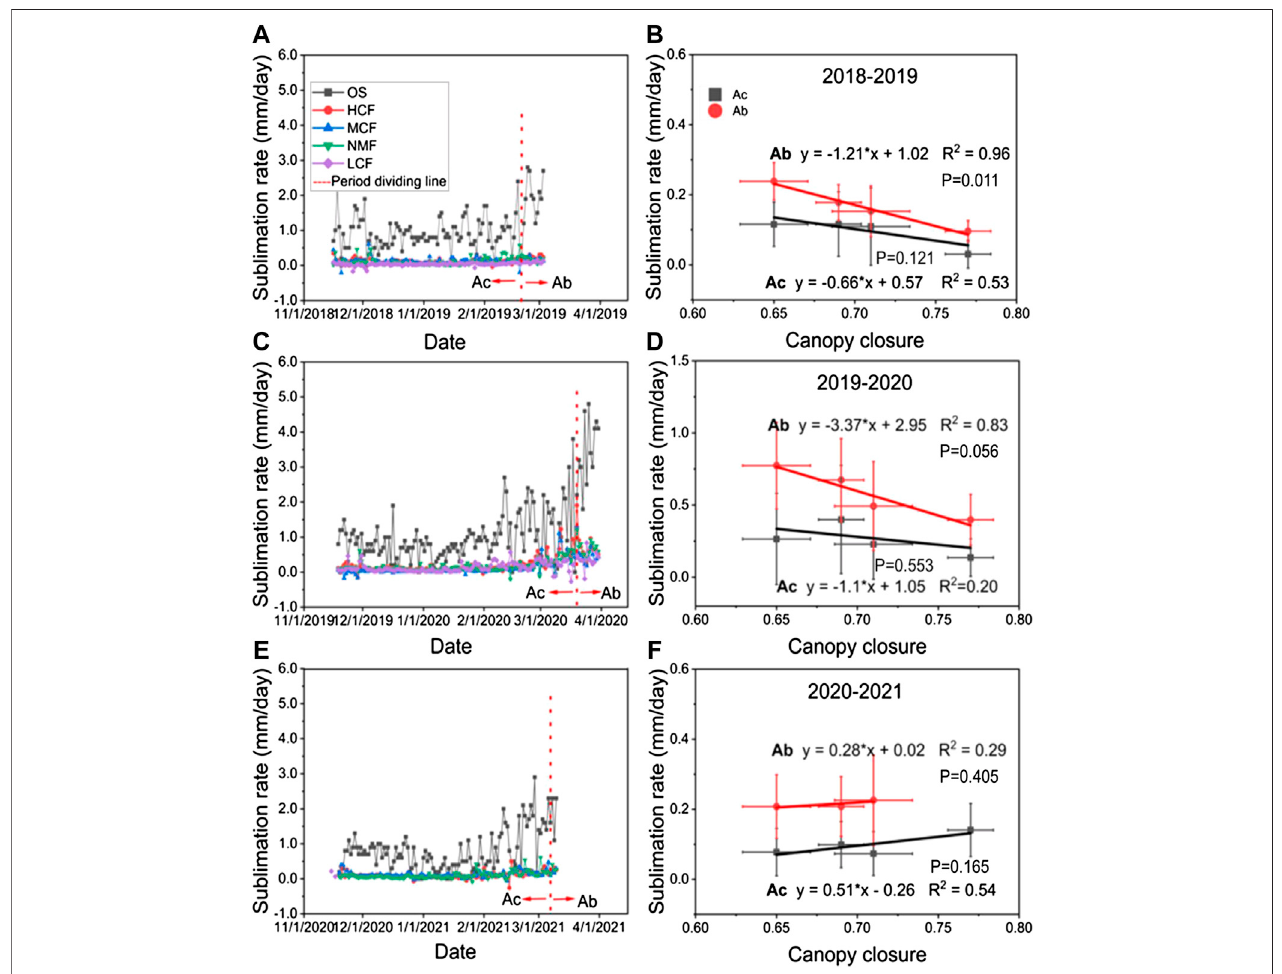
FIGURE 9 | Snow sublimation rate ( S s ) daily dynamics of fi ve sites: (A) 2018 – 2019, (C) 2019 – 2020, and (E) 2020 – 2021; the relationship between the multi-day average snow sublimation rate ( S s-A ) and forest canopy closure ( θ ) in the different periods: (B) 2018 – 2019, (D) 2019 – 2020, and (F) 2020 – 2021. Ac is the accumulation period (right column, grey point), Ab is the ablation period (right column, red point), and red dotted line (left column) is the dividing line for the Ac and Ab periods.